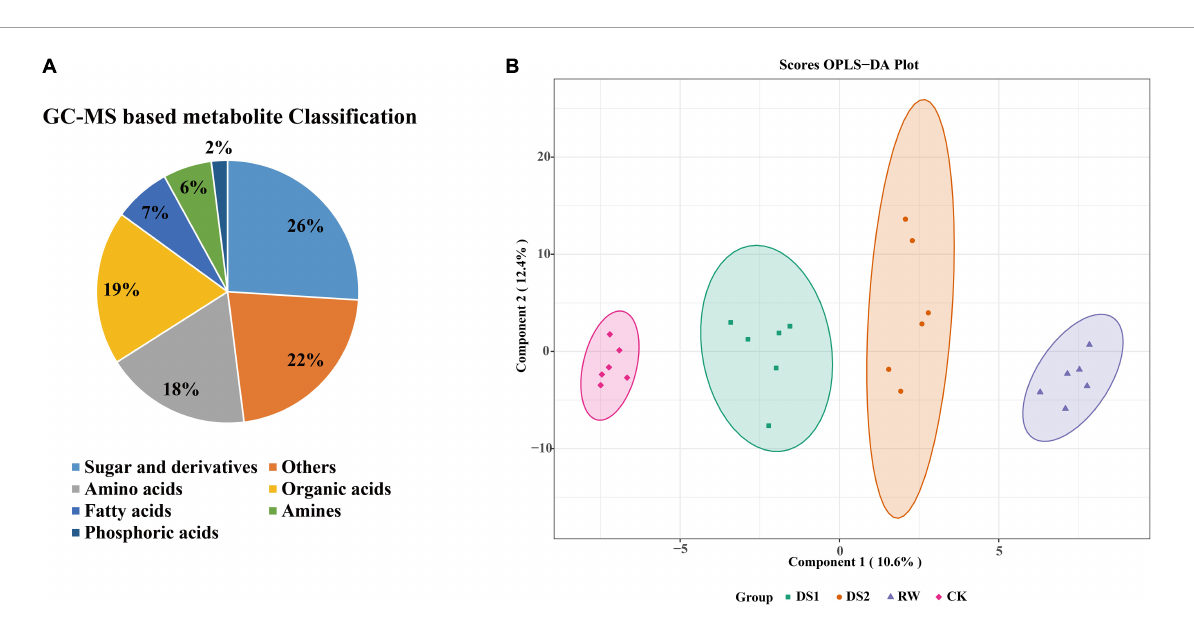
FIGURE2 Pie chart of metabolite classification (A) and OPLS-DA score plots for metabolic profiling analysis (B) . The score of variation explained by each principal component is indicated on the axes. Each point corresponds to a plant sample, and different colors indicate the different treatments.